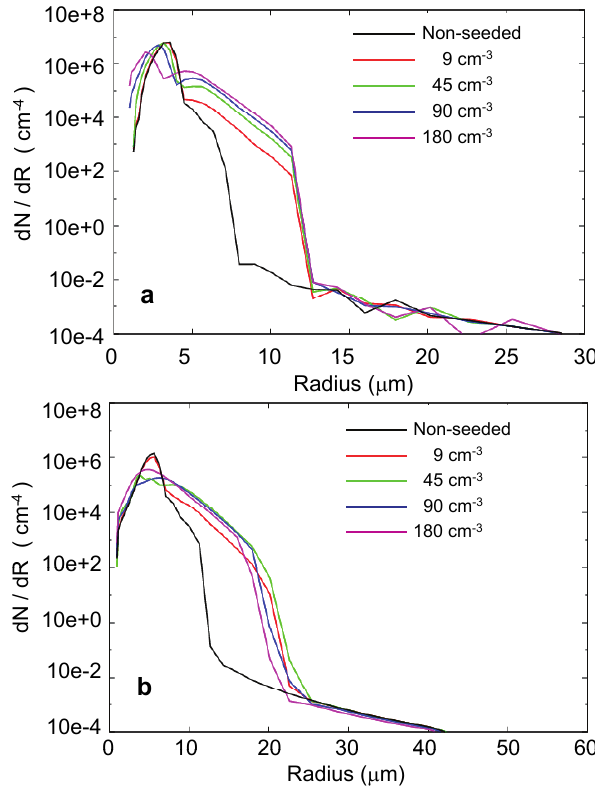
Fig. 9. Cloud droplet size distributions at 100m above the base of the cloud center for the shallow convective cloud case (updraft velocity is about 4ms − 1 ) at 11.5min (a) and for the stratiform cloud case (updraft velocity is about 0.3ms − 1 ) at 68.5min (b) . The black line indicates the droplet size distribution for the non-seeded case. For seeded cases, different total number concentrations of salt micro-powder are seeded under the cloud base: 9cm − 3 (red line), 45cm − 3 (green line), 90cm − 3 (blue line), or 180cm − 3 (pur- ple